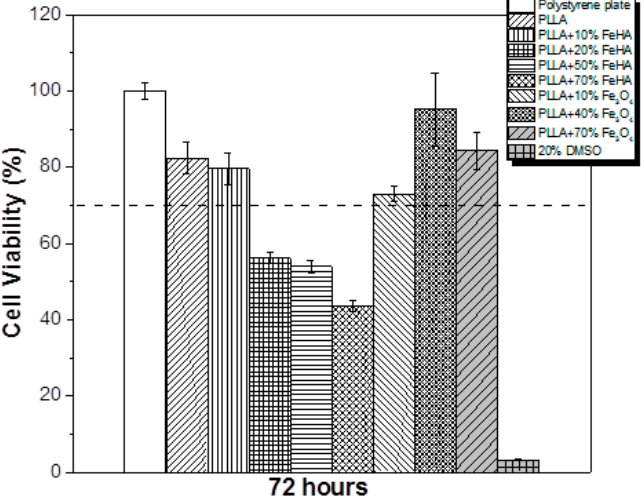
Figure 10. Cell viability of MC3T3-E1 pre-osteoblast cells in contact with the as-prepared extraction media exposed with the different samples up to 72 h.